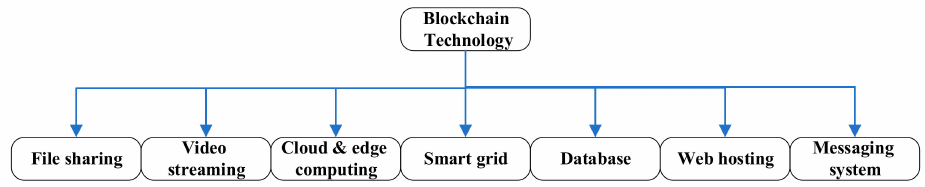
Figure 2. The applications of blockchain